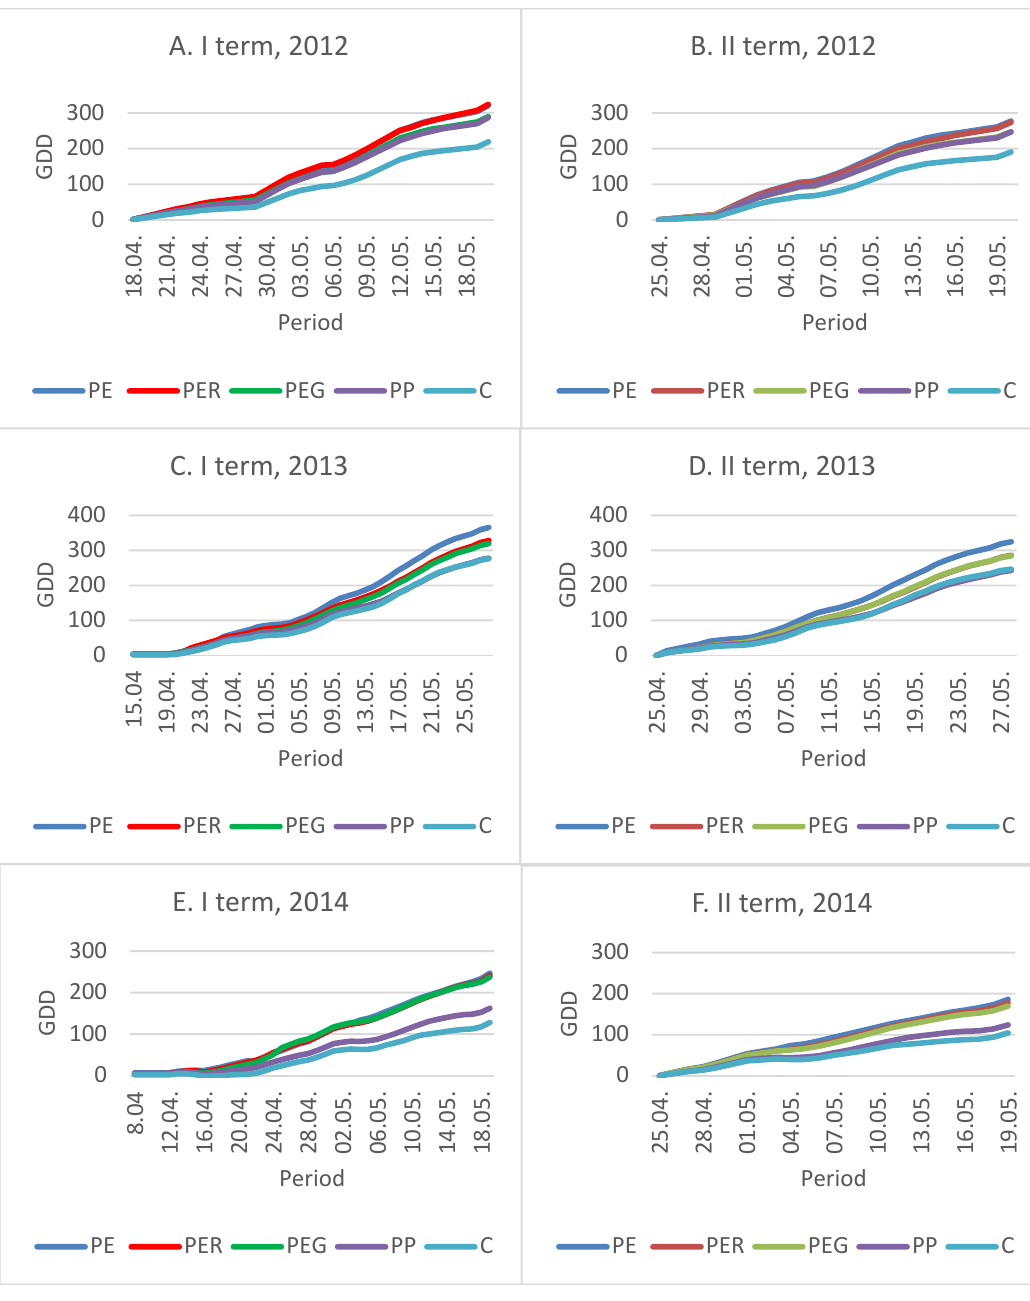
Figure 3. Cumulative sum of mean daily temperature within maize plant cover period ( ° C). ( A ) First sowing term 2012, ( B ) second sowing term 2012, ( C ) first sowing term 2013, ( D ) second sowing term 2013, ( E ) first sowing term 2014, ( F ) second sowing term 2014.